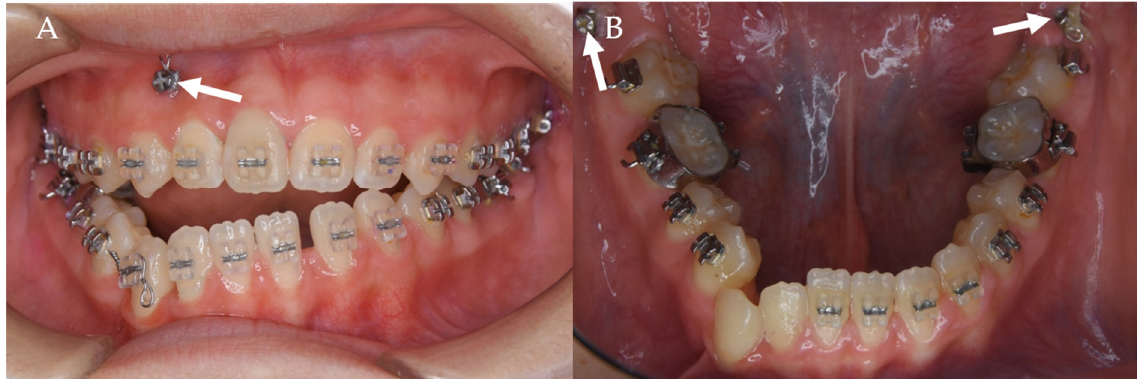
Figure 6. Intraoral photographs after insertion of TADs. ( A ) front view; ( B ) lower occlusal view. Arrows indicate TADs.